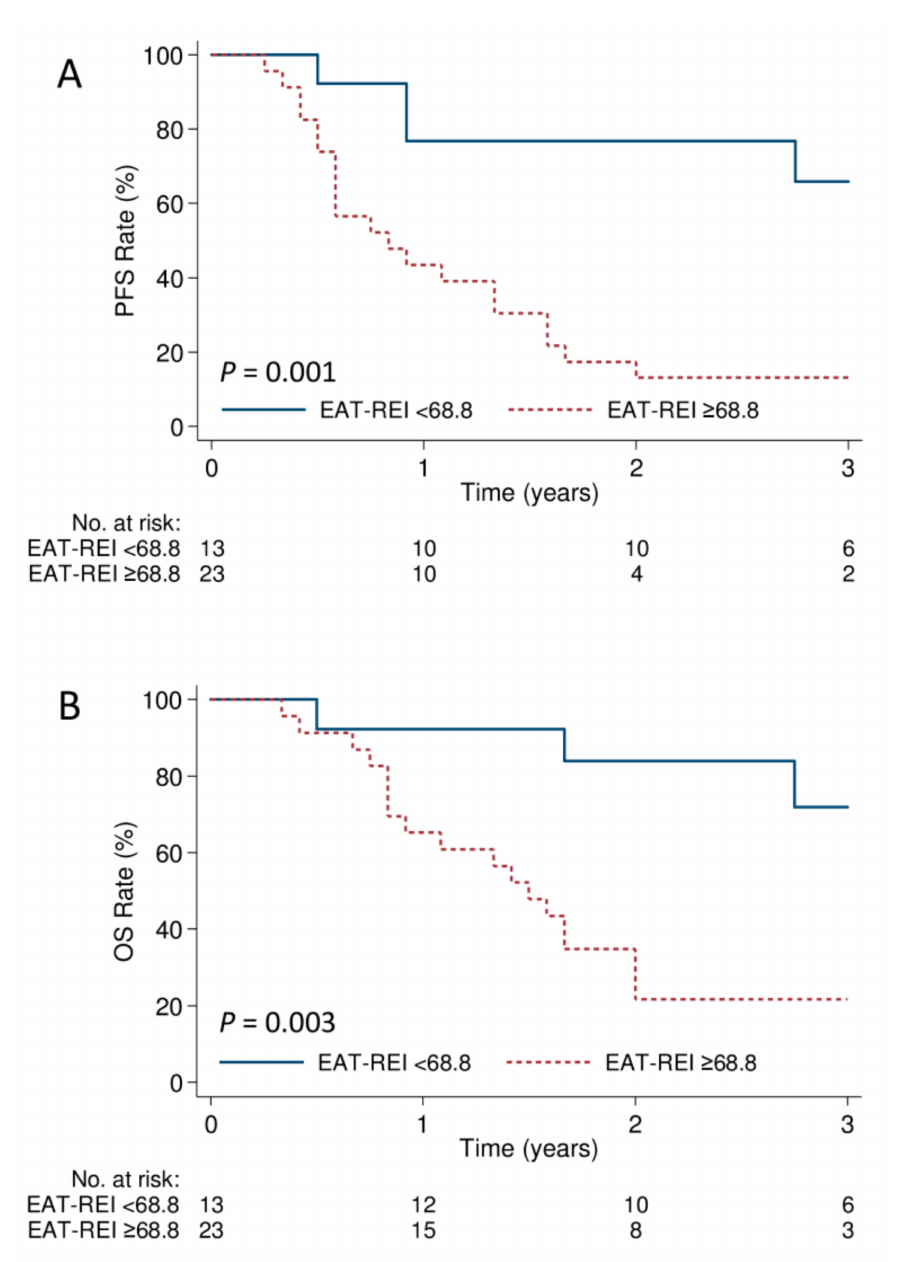
Figure 3. Kaplan–Meier estimates of the 3-year ( A ) progression-free survival p = 0.001 and ( B ) overall